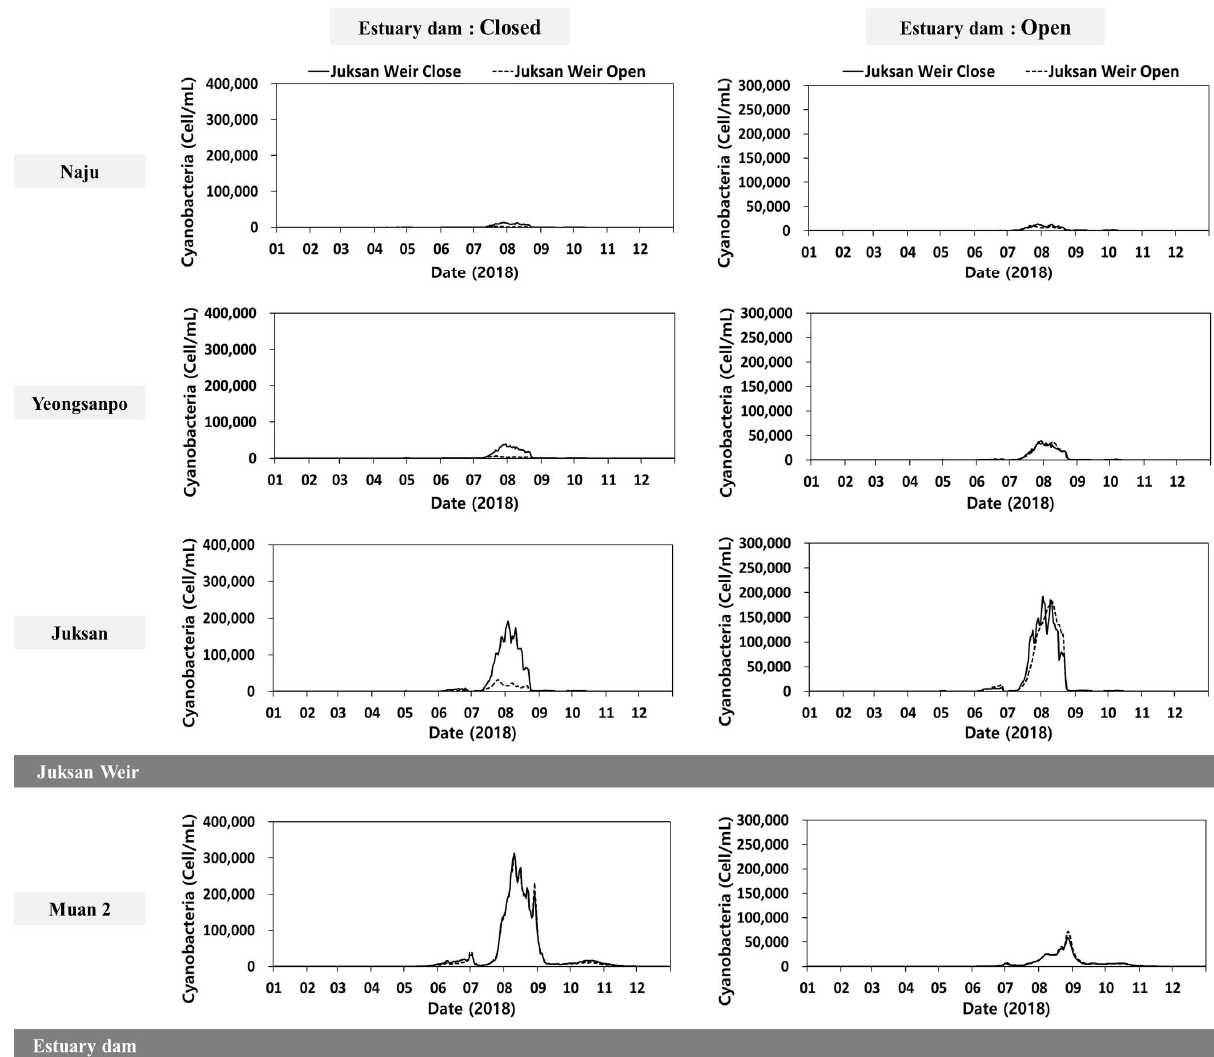
Figure 7. Simulated cyanobacterial concentrations according to the operating conditions of the Juksan Weir and estuary dam.